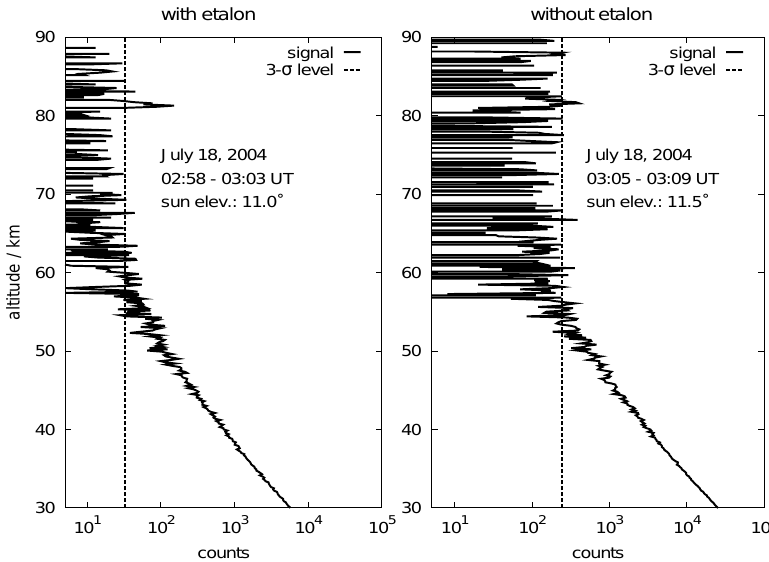
Fig. 4. Lidar observation of a noctilucent cloud during daylight conditions. The left plot shows data using an etalon as daylight filter, whereas the right plot shows data taken without etalon filtering. The measurements are from 18 July 2004, at a solar elevation angle of 11 ◦ . The solid lines represent the background subtracted lidar data. The dashed line is the 3- σ level of the background signal.